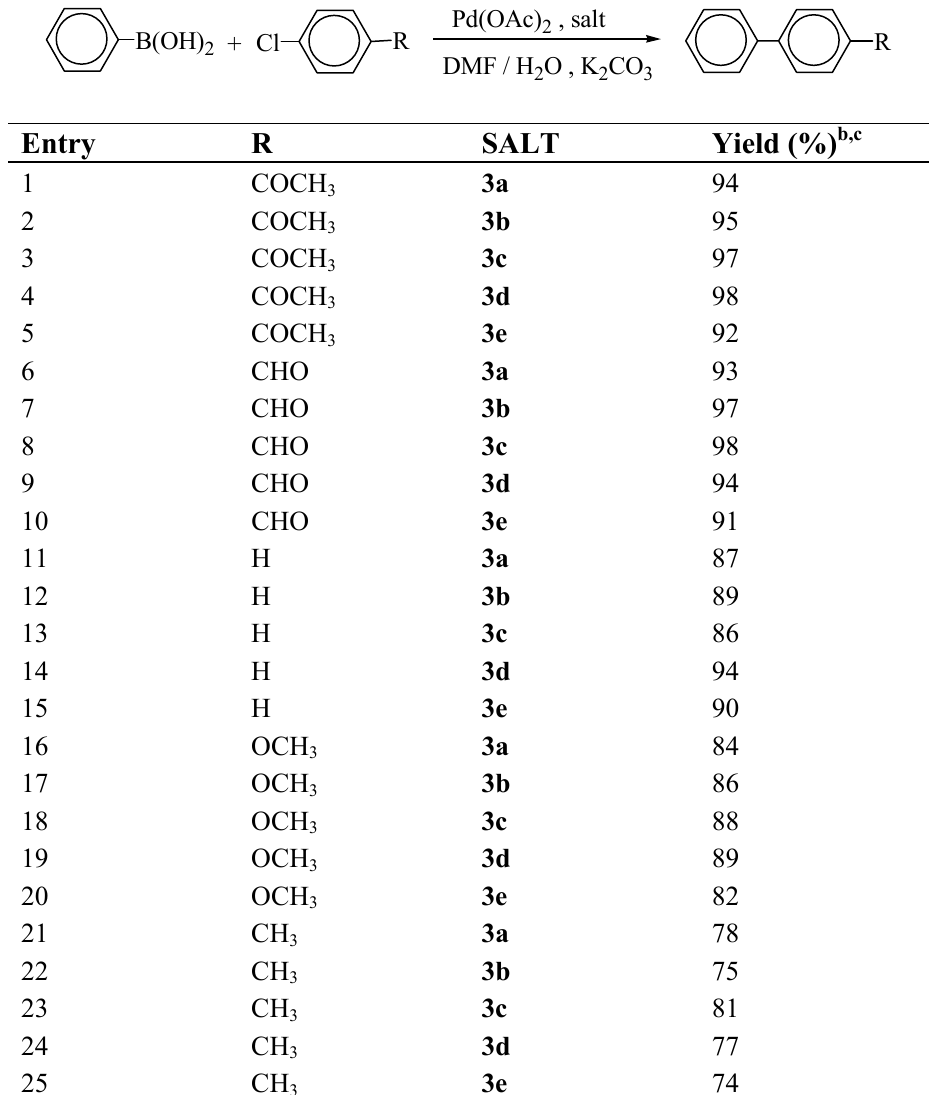
Table 2. The Suzuki coupling reaction of aryl chlorides with phenylboronic